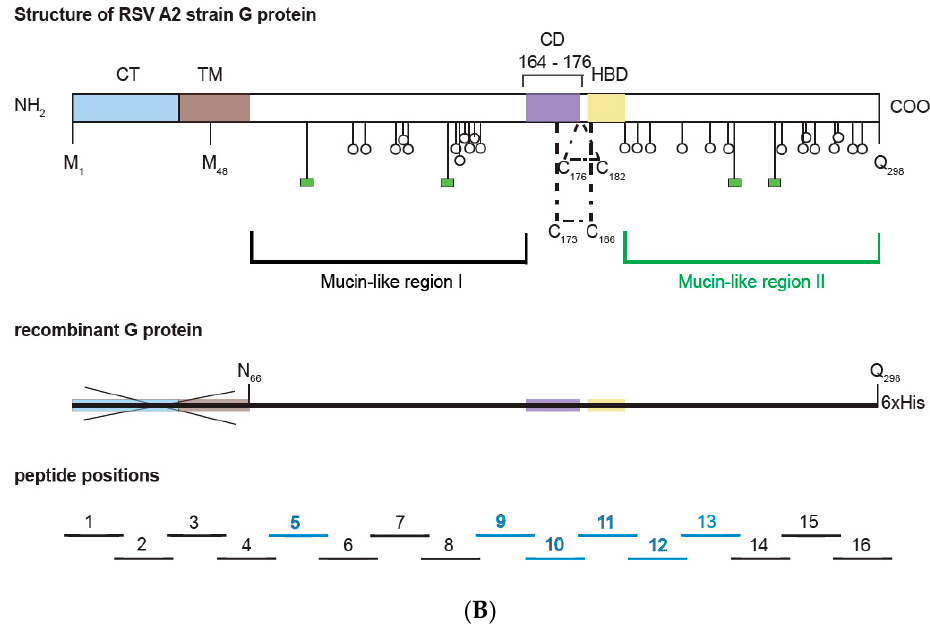
Figure 1. ( A ) Alignment of the amino acid sequences of G proteins from distantly related strains from subgroup A and B. Subgroup A and B sequences as indicated on the left margins (gene identifier-gi- numbers indicated) were aligned with the G protein sequence from A2 strain (subgroup A) on the top. Dots show identical amino acids and dashes indicate gaps. The membrane-anchored form (Gm) starts with methionine M-1 and the secreted form (Gs) with M-48. The two mucin-like regions are indicated by a black (mucin-like region I) and by a green (mucin-like region II) frame. Conserved cysteine residues are denoted by red boxes and predicted N- and O-linked glycosylation sites by highlighting the consensus sequence NXT/S in green and with small blue ovals, respectively. A CX3C- like motif similar to one in the chemokine CX3CL1 (fraktalkine) is indicated by a brown bar in the Cysteine noose which is stabilized by two disulfide bonds in the center of the protein. The N-terminal cytoplasmic tail (CT) is boxed in blue, the hydrophobic transmembrane anchor (TM) in brown, the Heparin-binding domain (HBD) in pale orange and the central conserved domain in green. The pink regions in subgroup B RSV strains are duplicated. Synthetic peptides (GP1–GP16) used for epitope mapping spanning the G protein sequence are indicated by black horizontal lines. ( B ) Overview of the G protein structure showing the different domains and N- as well as O-linked glycans. Below, the recombinant G protein construct and overlapping peptides 1–16 (IgG-reactive peptides in blue) are indicated. Blue * represents the Cytoplasmic Tail and is described in figure legends.